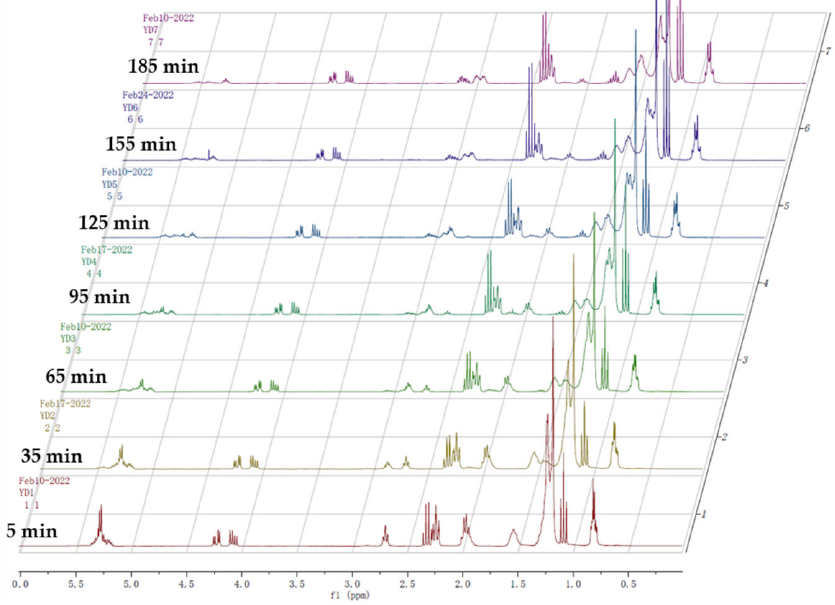
Figure 2. NMR spectra of CSO (cottonseed oil) and ECSO (epoxidized cottonseed oil).